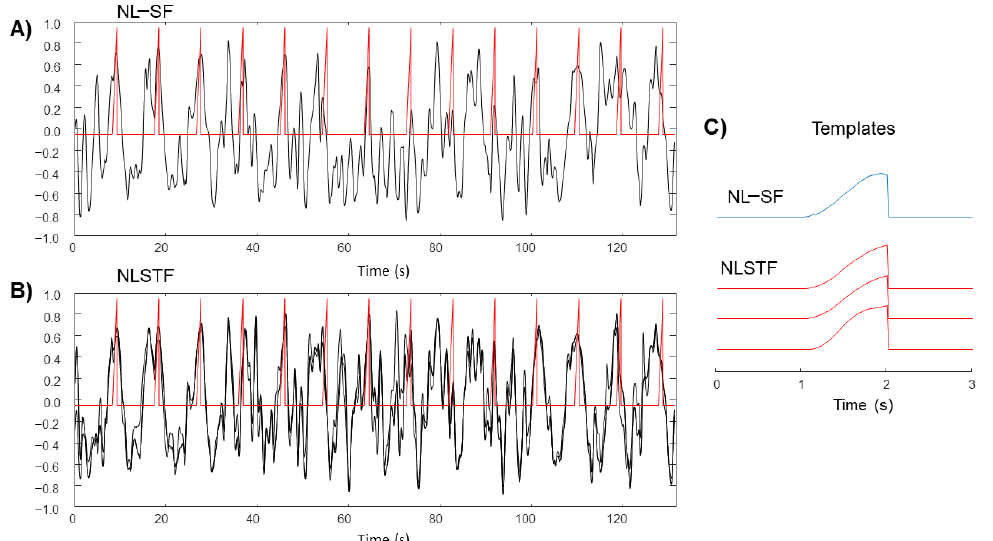
Figure 3. Example of processing (same data as in Figure 2 are used). ( A ) Output of the Non-Linear Optimized Spatial Filter (NL-SF) on test data, after template matching (reference prototype indicating movements onset in red). ( B ) Outputs of the three best Non-Linear Spatio-Temporal Filters (NLSTF) on test data, after template matching. ( C ) Templates of the filters (NL-SF and the 3 best NLSTFs), obtained by averaging the outputs of the filters on MRCPs of the training